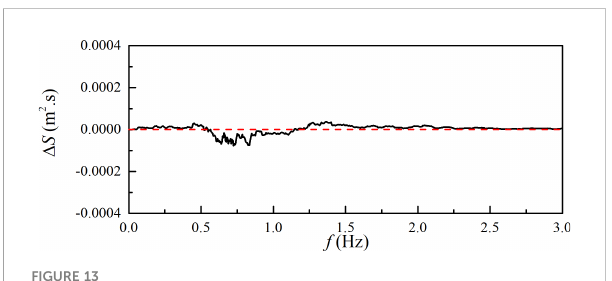
FIGURE 13 The difference of spectra between the stations 8 # and 7 # for case RJ 7 .